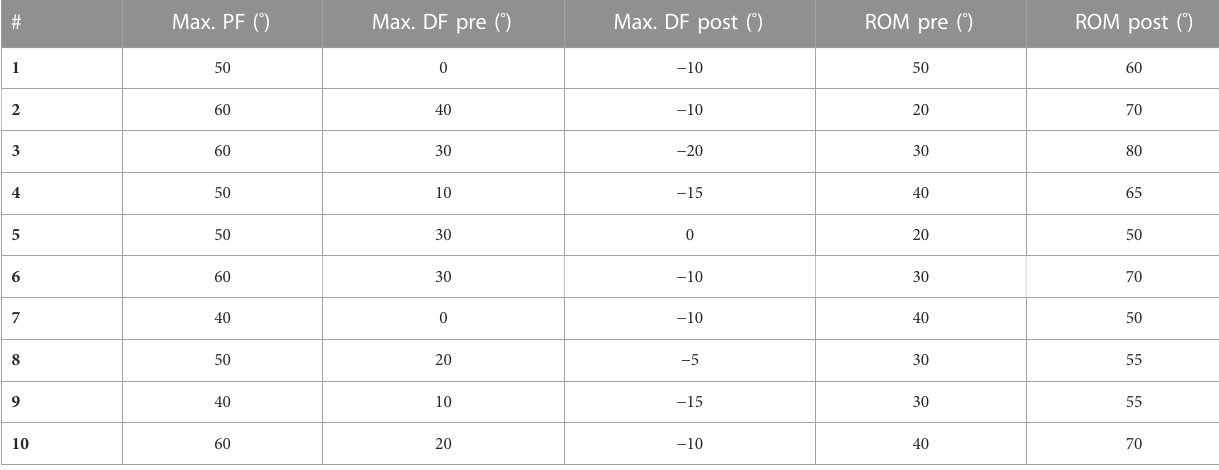
TABLE 2 Ankle passive range of motion measured pre- and